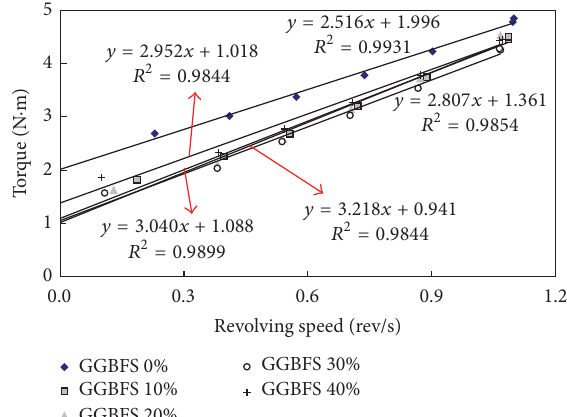
Figure 5: Exerted torque versus rotational speed relationship for silica fume mixtures.